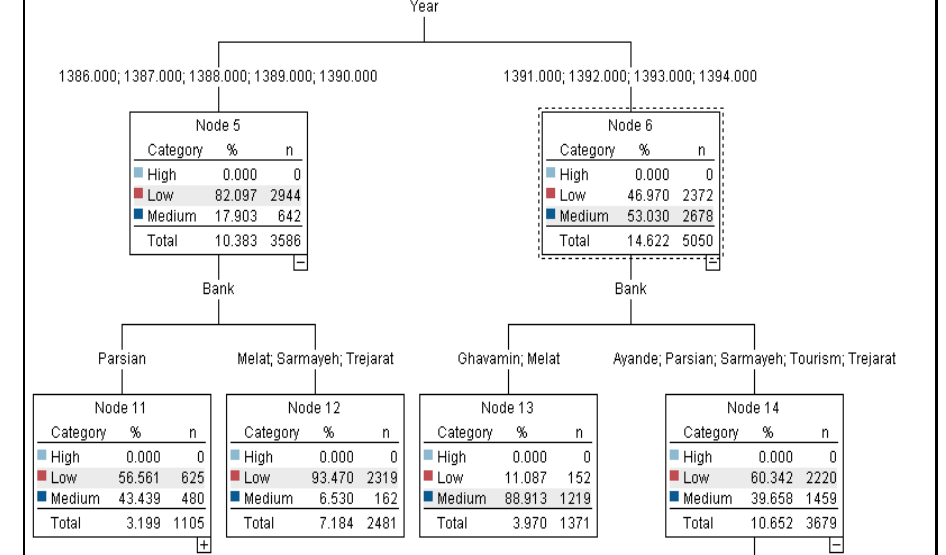
Figure 11. Branches of rule 18 & rule 19.